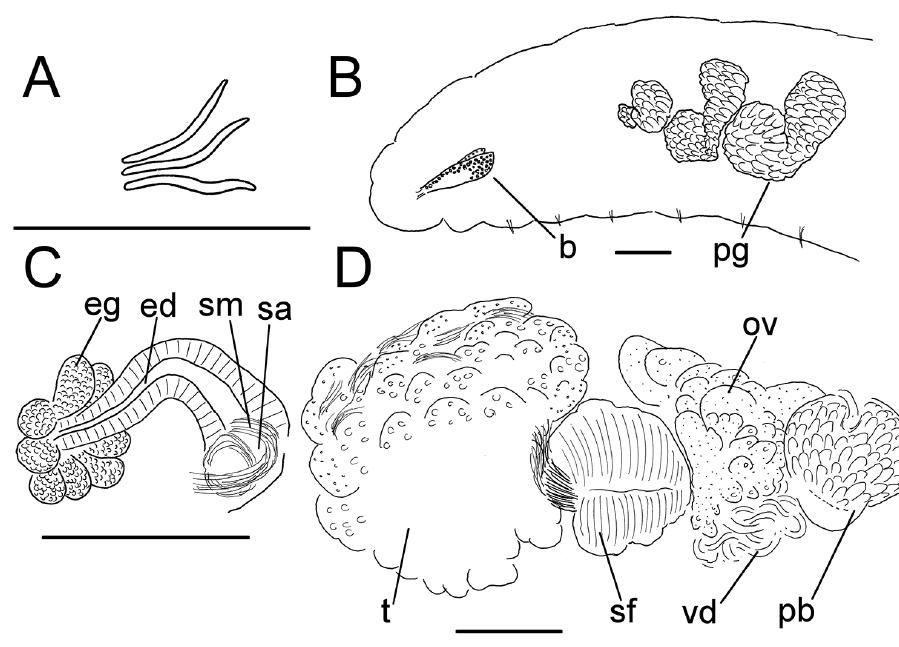
Figure 19. Lumbricillus buelowi . A Chaetal bundle B Anterior body C Spermatheca D Other genitalia. Abbreviations under general notes. Scale bars: 100